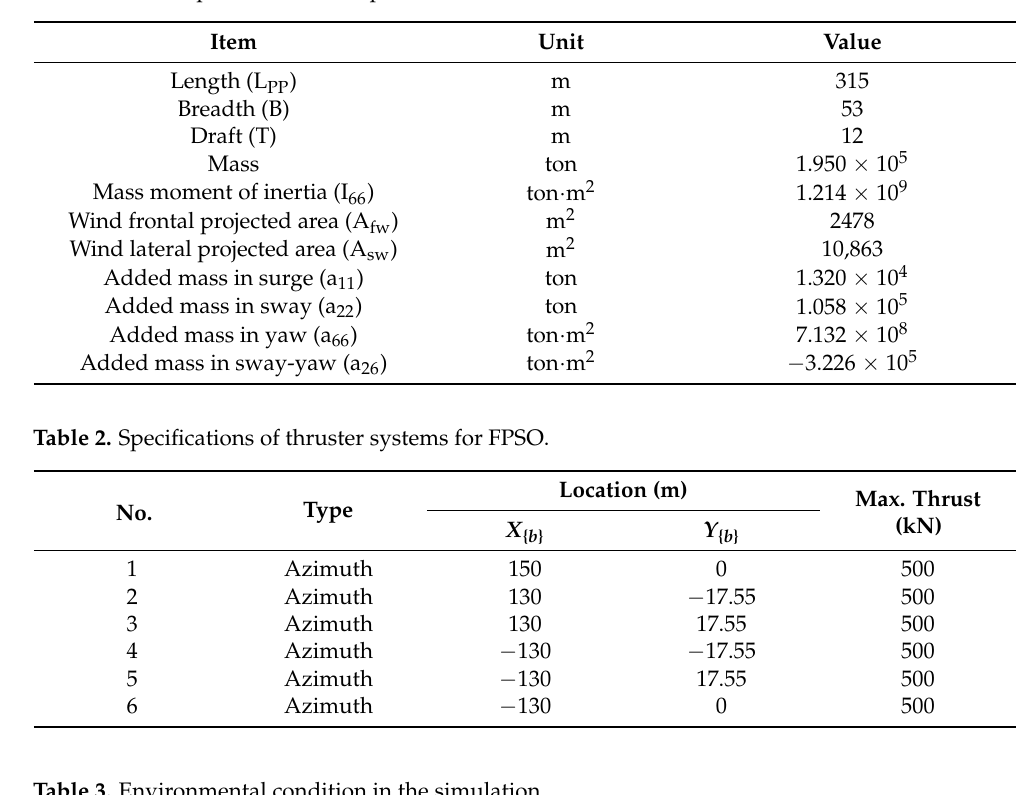
Table 1. Vessel Specifications and parameters of FPSO.